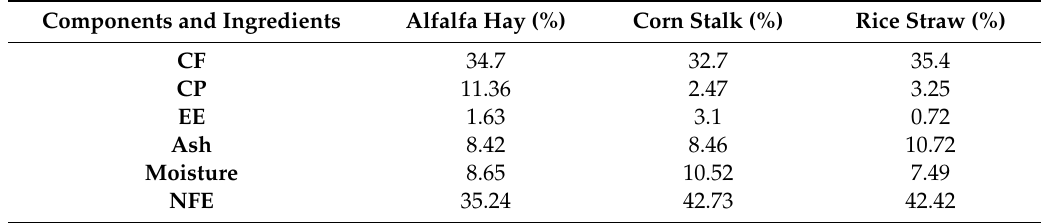
Table 1. Feed sample composition for experimental